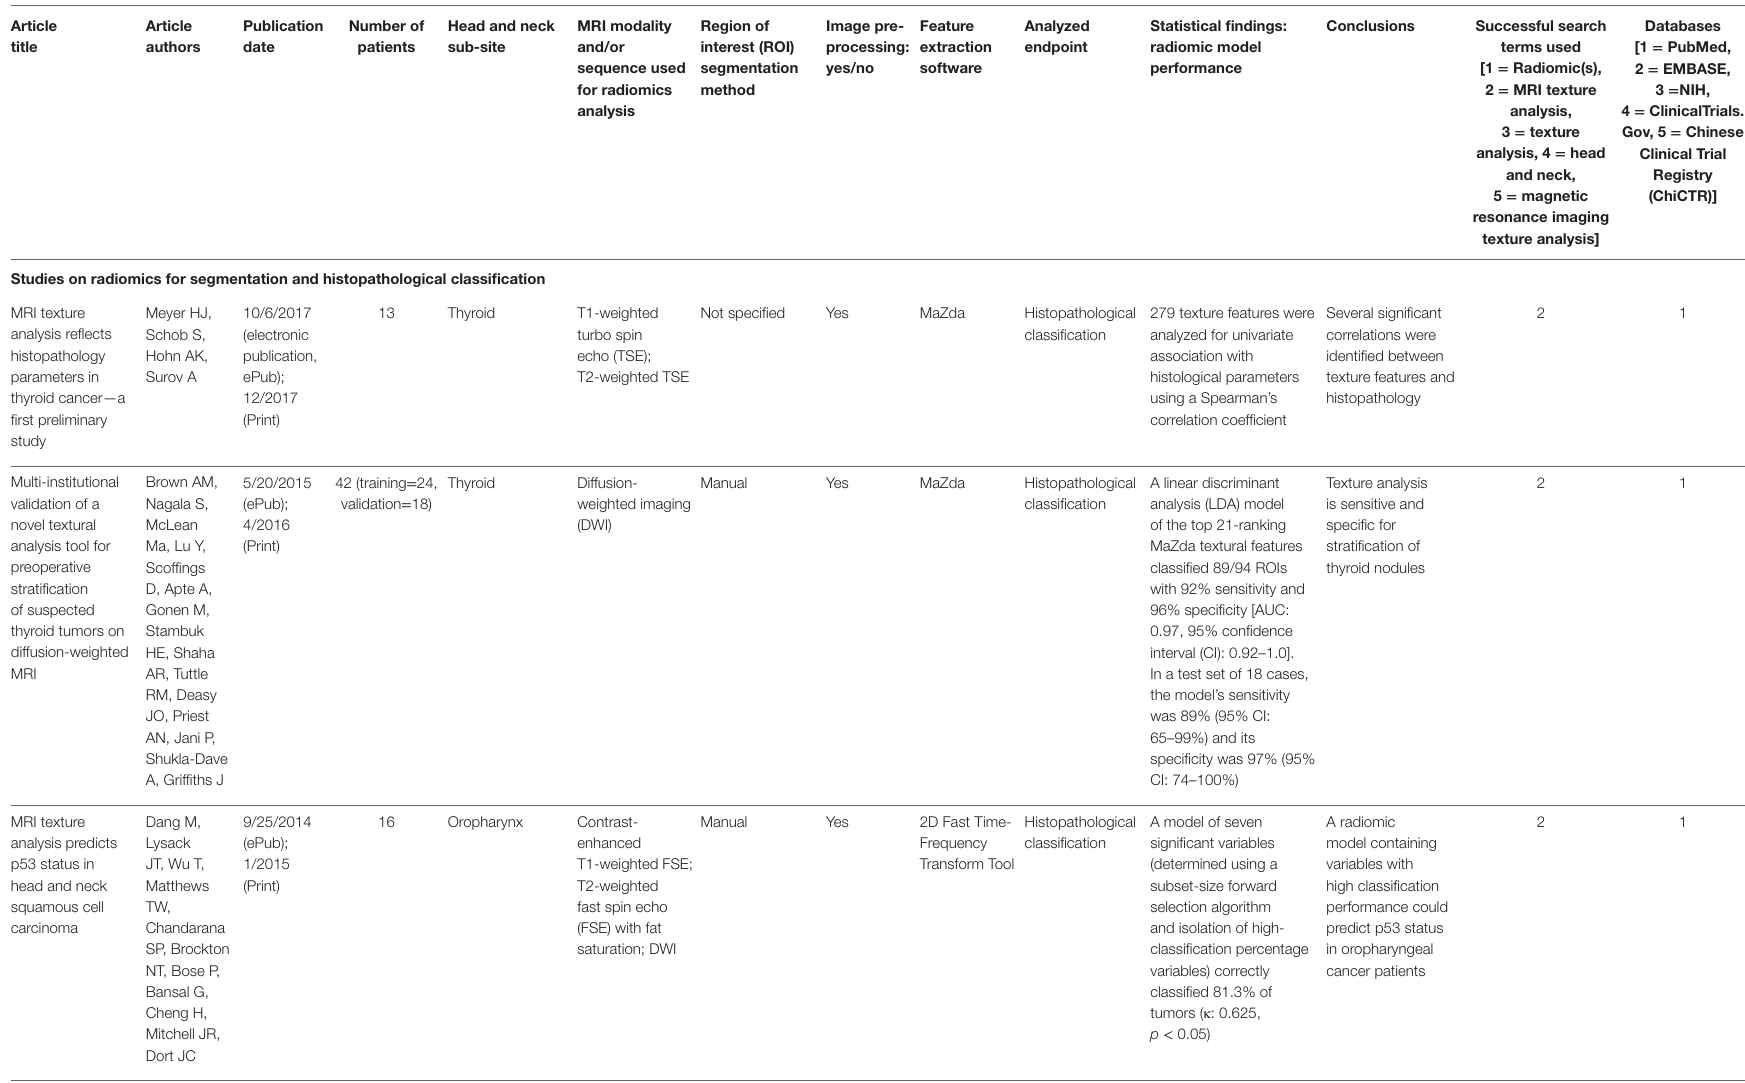
taBLe 1 | Magnetic resonance imaging (MRI) radiomics in HNC: completed studies